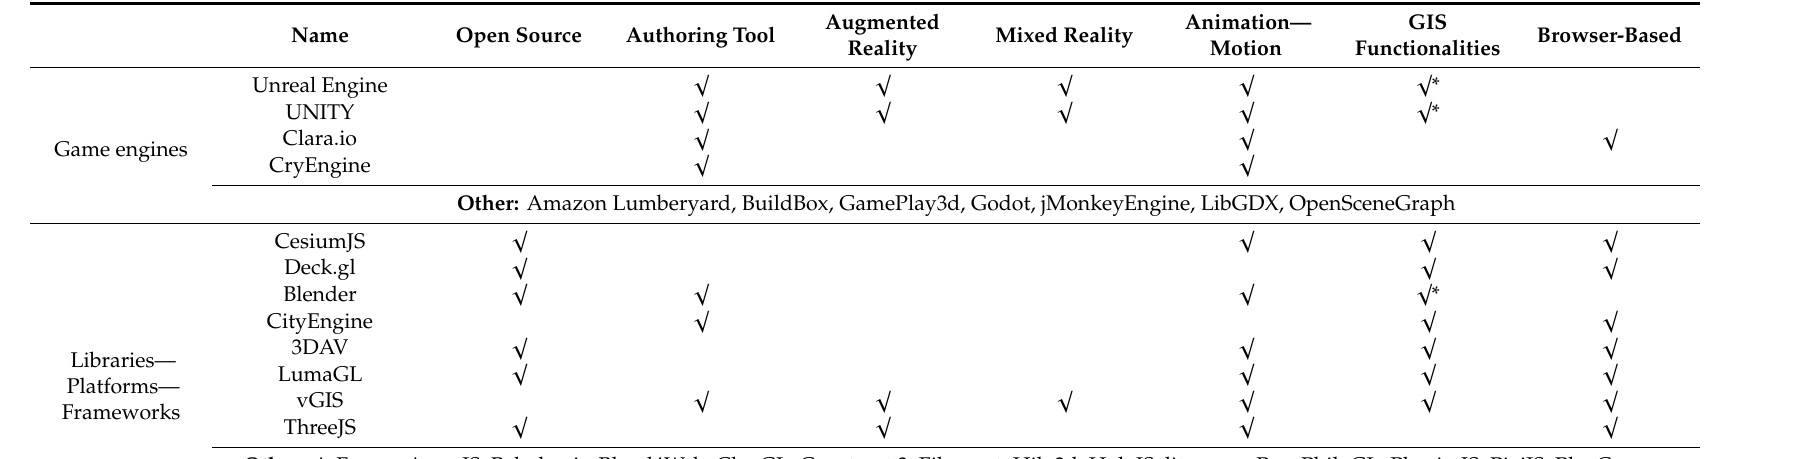
Table 1. An extensive review of related state-of-the-art